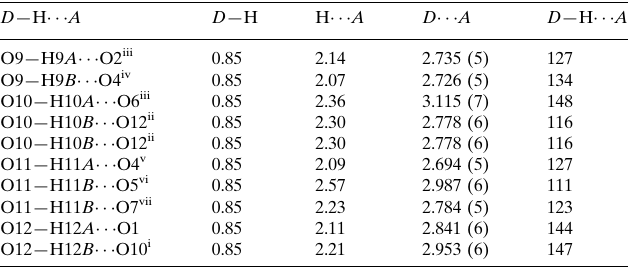
Hydrogen-bond geometry (A˚ , (cid:2)